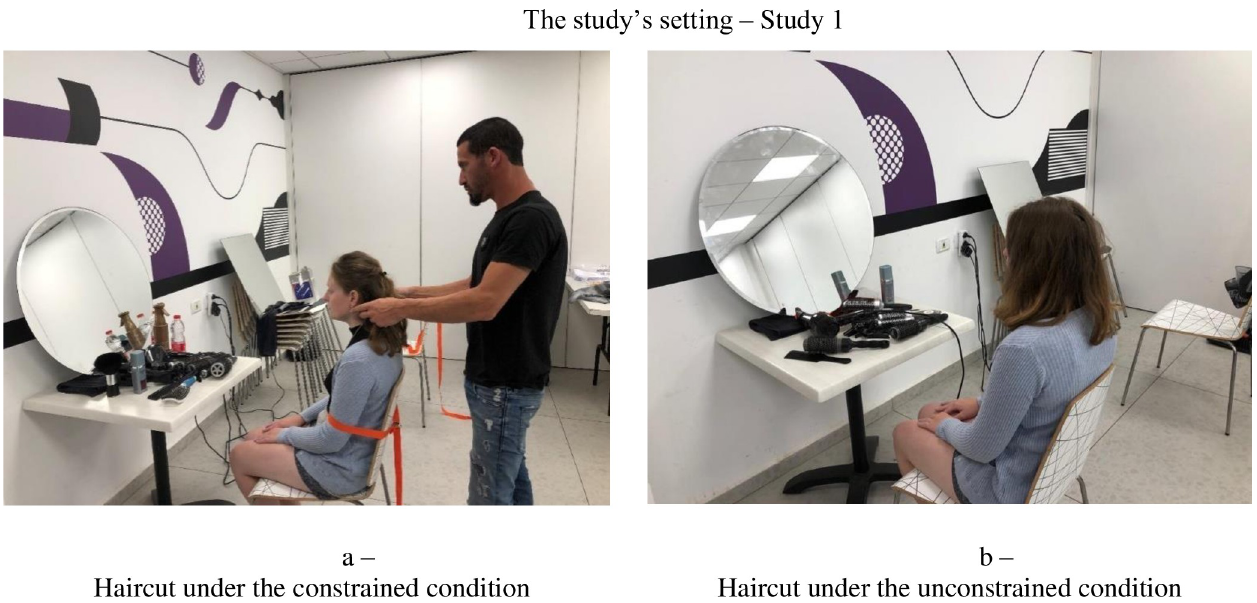
Fig 1. The study’s setting–Study 1. a. Haircut under the constrained condition. b. Haircut under the unconstrained condition.